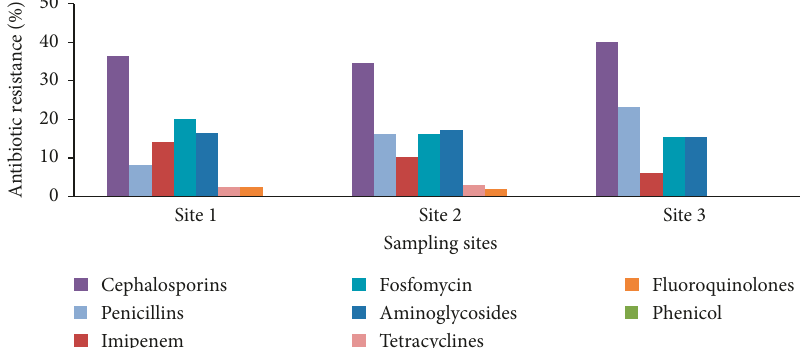
Figure 3: Distribution of antibiotic resistance prevalence among the three sampling